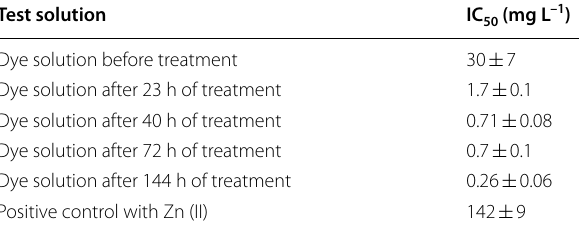
Table 4 Toxicity values of IC50 of Lactuca sativa L at different dye treatment times with Leucosporidium muscorum F20A. Data are presented as the mean DS ( n ± =